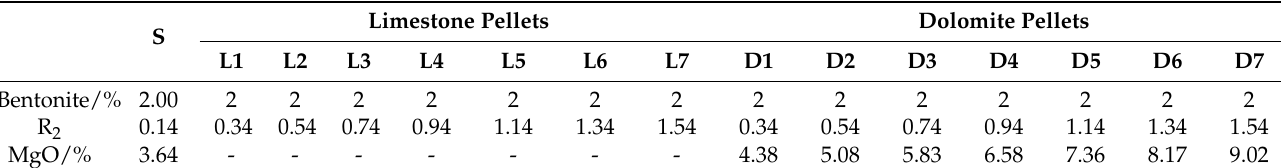
Table 3. Basic physical properties of bentonite.